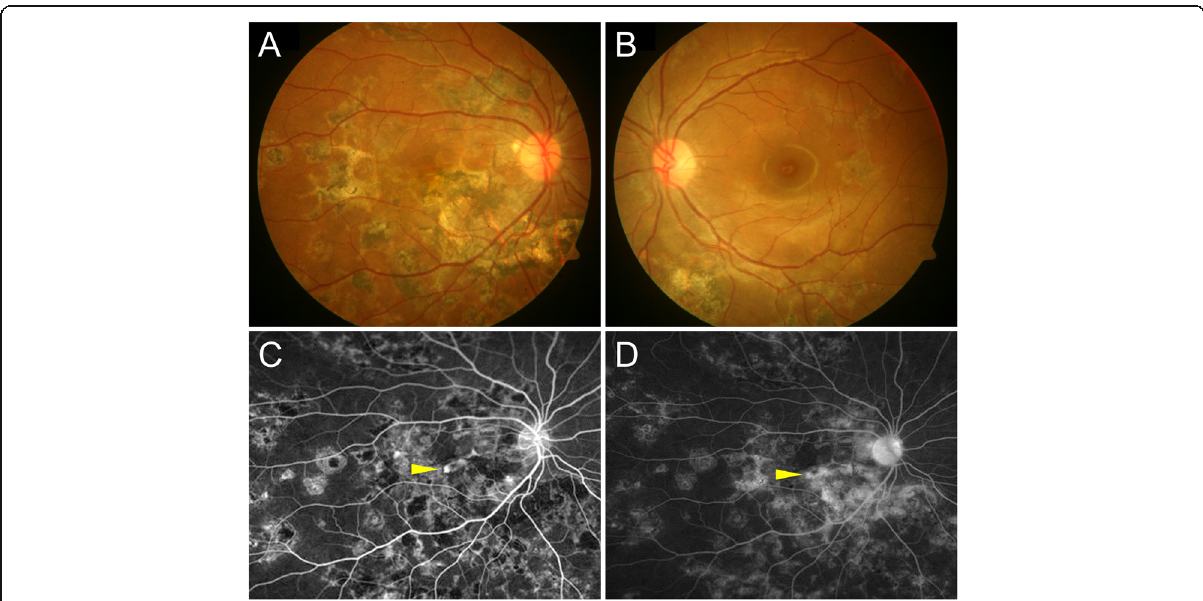
Fig. 1 The detection of inflammatory choroidal neovascularization on fluorescein angiography in a patient with tubercular serpiginous-like choroiditis. Fundus photograph of the right eye shows healed choroiditis lesions in the right eye ( a ) and the left eye ( b ). Fluorescein angiography of the right eye shows early hyperfluorescent lesion in the foveal region (yellow arrowhead) ( c ). The late phase angiogram shows progressive hyperfluorescence of the foveal lesion suggestive of choroidal neovascularization (yellow arrowhead) with staining of the healed choroiditis lesions ( d